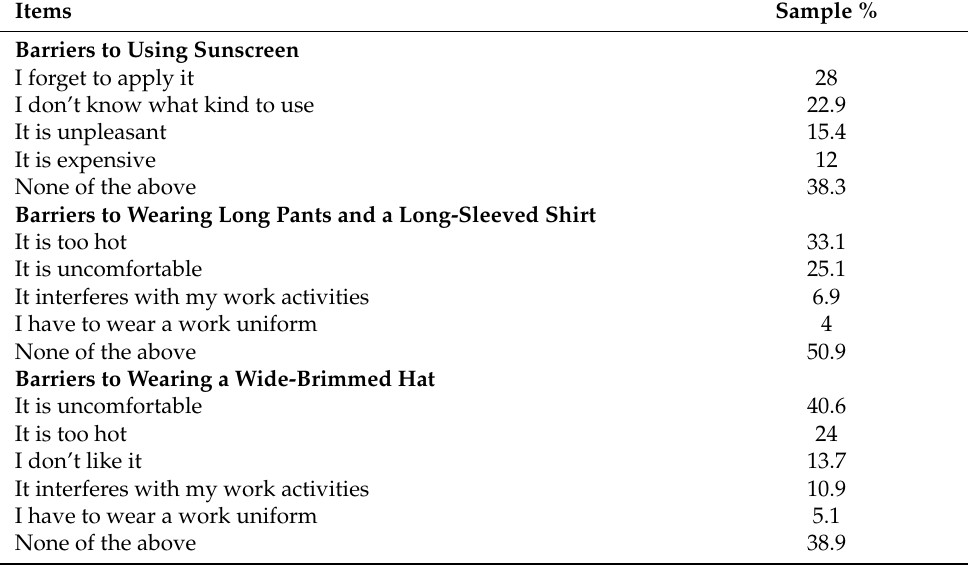
Table 4. Barriers to engaging in sun protection behaviors when working outside on warm, sunny days.